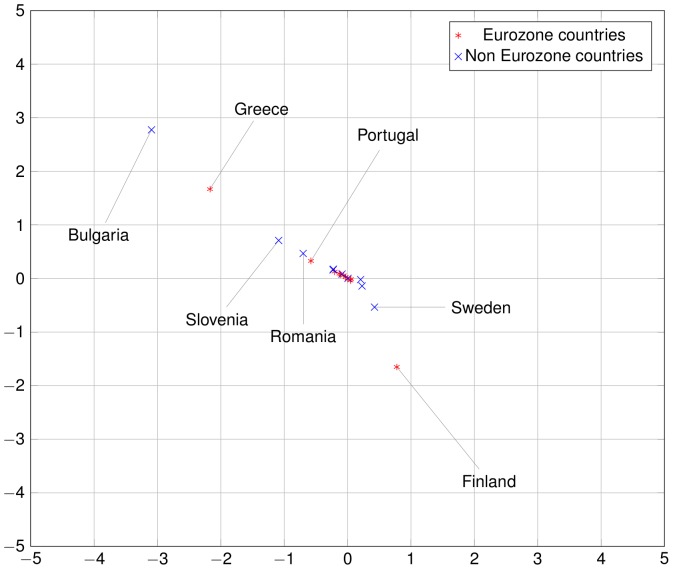
European economies in 2007.Compare with Figs. 9 and 10.